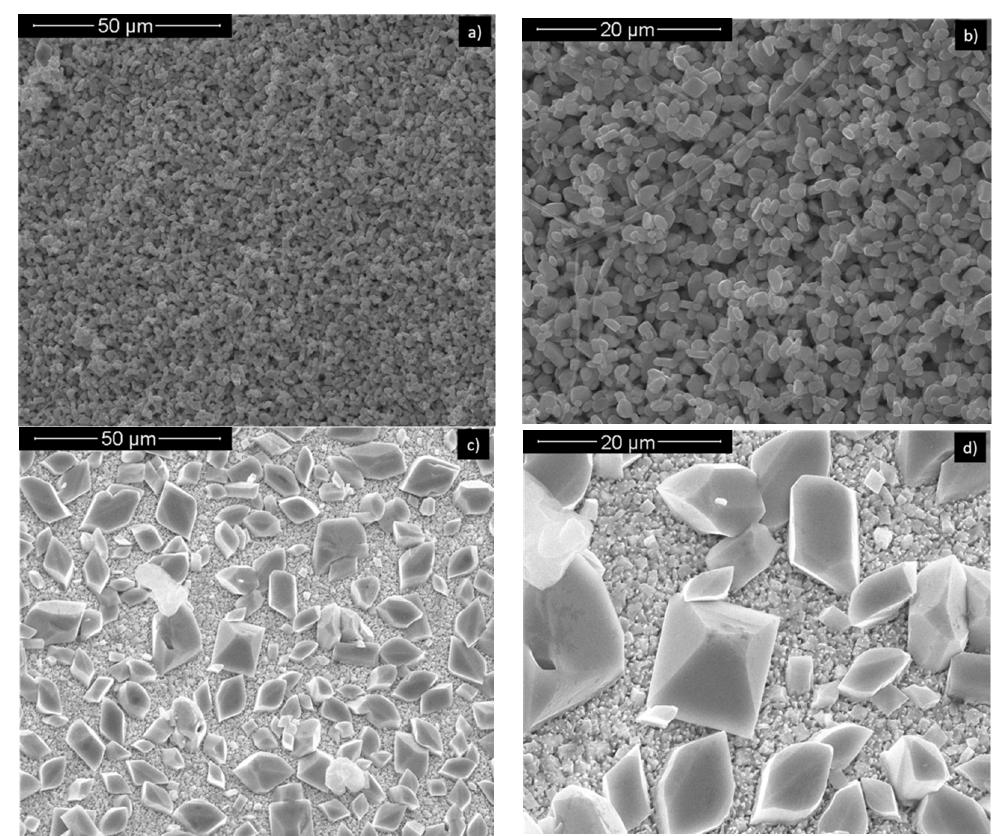
Figure 8. SEM images of Pb and PbO 2 NW electrodes after 1000 cycles at 10 C at the end of the 1000th discharge at − 20 ± 2 °C: ( a , b ) Pb electrode and ( c , d ) PbO 2 electrode.